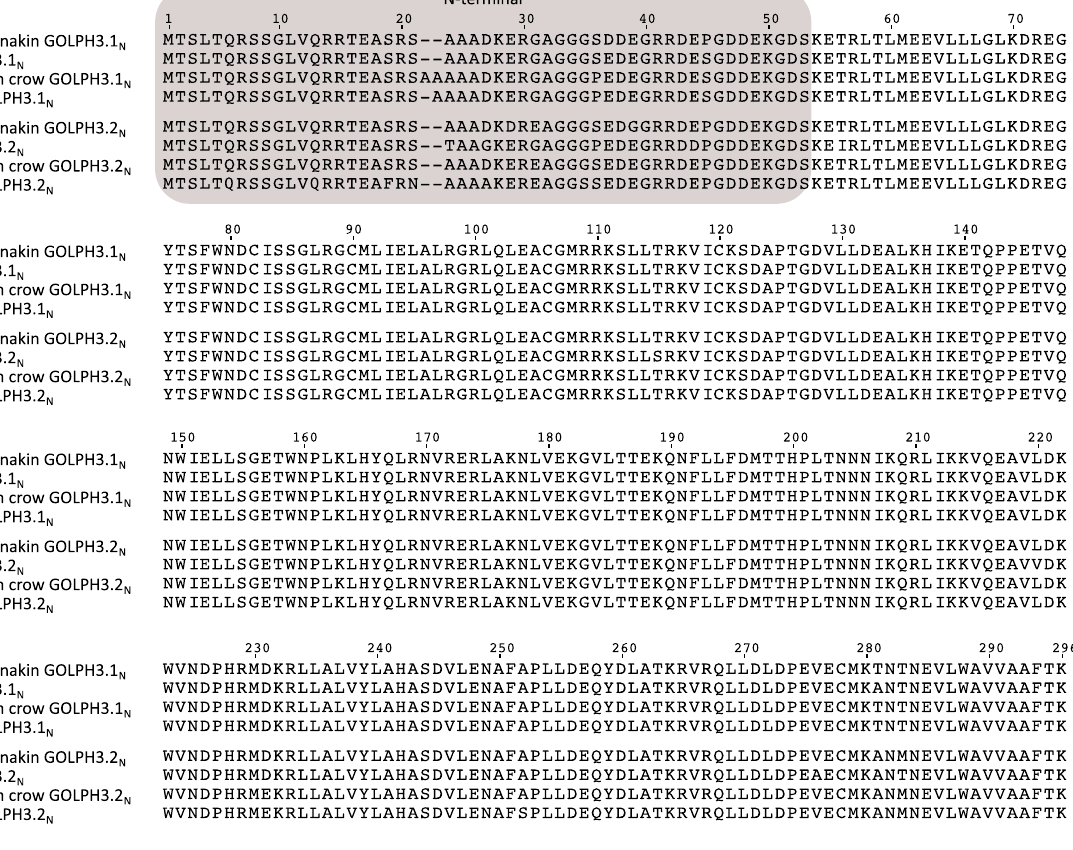
Figure 5. Alignment of Golgi phosphoprotein 3 (GOLPH3) amino acid sequences from lance tailed manakin ( Chiroxiphia lanceolata ), kakapo ( Strigops habroptilus ), New caledonian crow ( Corvus moneduloides ) and zebra finch ( Taeniopygia guttata ). The N-terminal region of the protein is